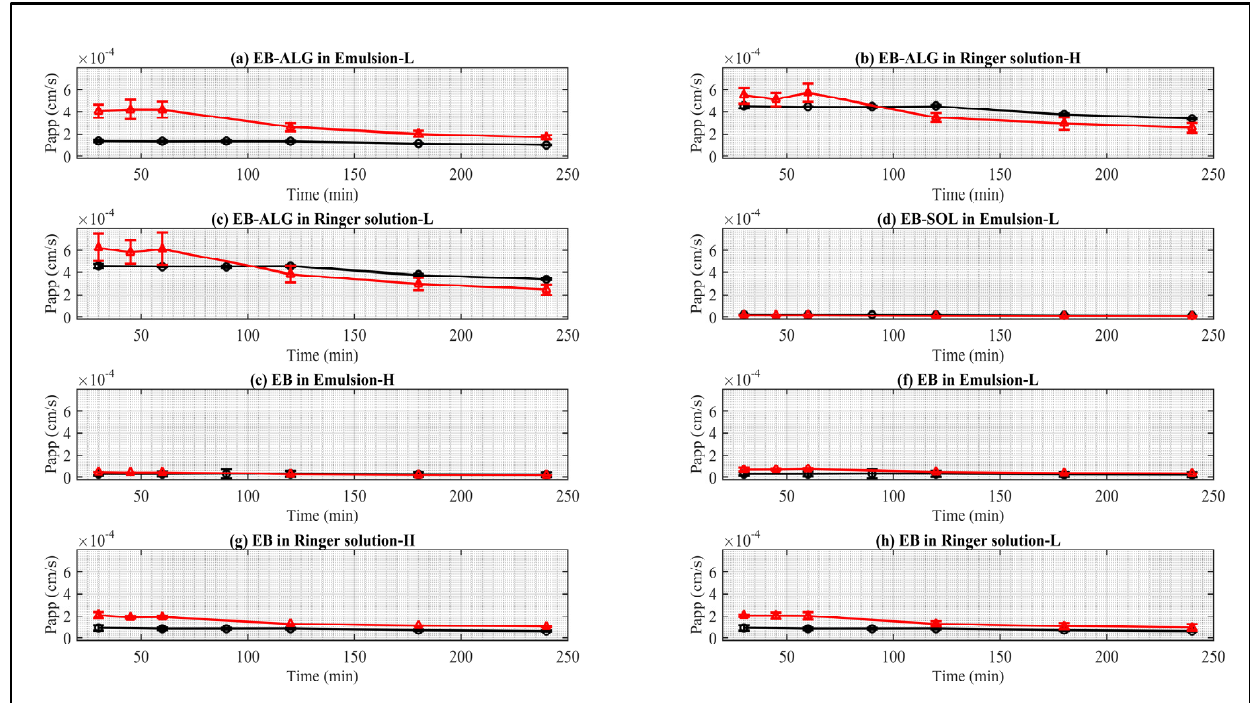
Figure 7. Comparison of Papp (cm/s) of synthetic membranes (red points) and biological membranes (black points). ( a ) Represents EB–ALG in emulsion as donor media with lipophilic membrane (EM–L) for FDC; ( b ) represents EB–ALG in Ringer solution as donor media with hydrophilic membrane (RS–H) for FDC; ( c ) represents EB–ALG in Ringer solution as donor media with lipophilic membrane (RS–L); ( d ) EB–SOL in emulsion as donor media with lipophilic membrane (EM–L) for FDC; ( e ) EB in emulsion with hydrophilic membrane (EM–H); ( f ) EB in emulsion as donor media with lipophilic membrane (EM–L); ( g ) EB in Ringer solution as donor media with hydrophilic membrane (RS–H); and ( h ) EB in Ringer solution as donor media with lipophilic membrane (RS–L). Values represent the mean with standard deviation, n = 3 for synthetic membrane and n = 5 for biological membrane.